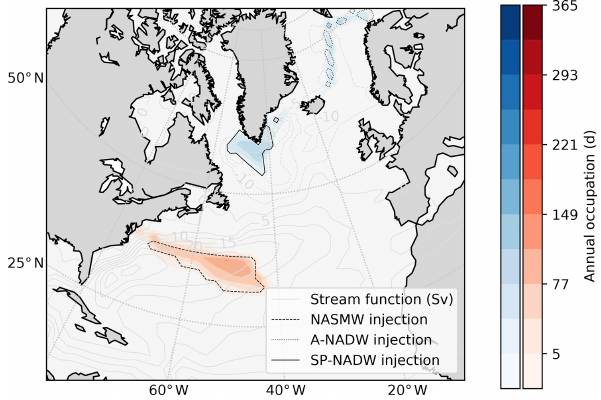
Figure 1. Outcrop locations of NASMW (red) and NADW (blue) from a 60-year climatology of the nonlinear model, following their respective definitions in Sects. 3 and 4. Shading indicates the num- ber of days of the year when the water mass is found at a given latitude and longitude. Light grey contours show the time-mean barotropic stream function for the North Atlantic. The dashed (solid or dotted) contour shows the distribution of the dye injection which initialises the tangent-linear run for NASMW (SP-NADW or A- NADW) at the annual maximum – see Sects. 3.2 (4.2.1 or